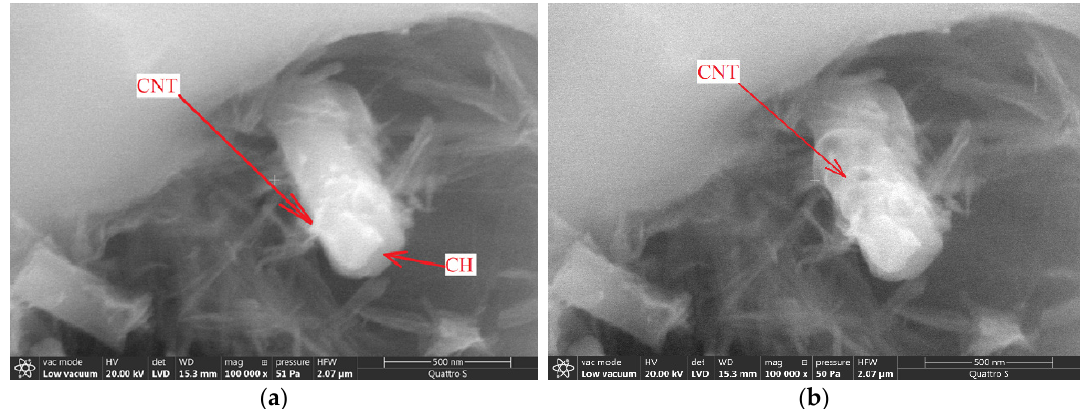
Figure 10. Calcium hydroxide with nanotubes: morphology at the initial moment of study ( a ), changes in morphology under the influence of an electron beam ( b ).